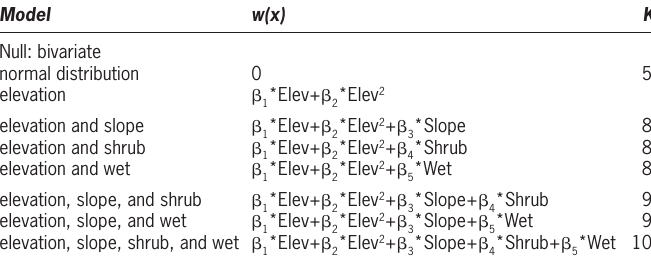
Table 1. Initial candidate models for analyzing individual habitat selection and estimating home ranges of 21 caribou in central Alaska. Model w(x)